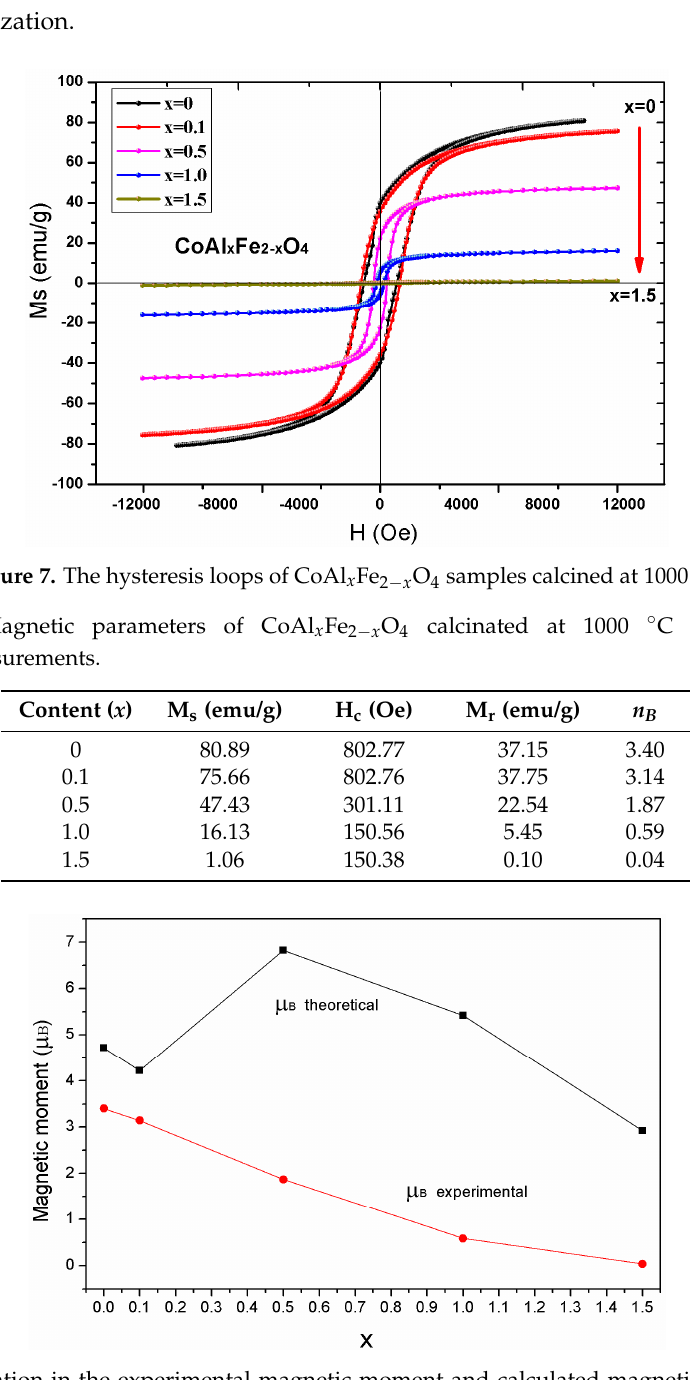
Figure 8. Variation in the experimental magnetic moment and calculated magnetic moment with changes in aluminum concentration.